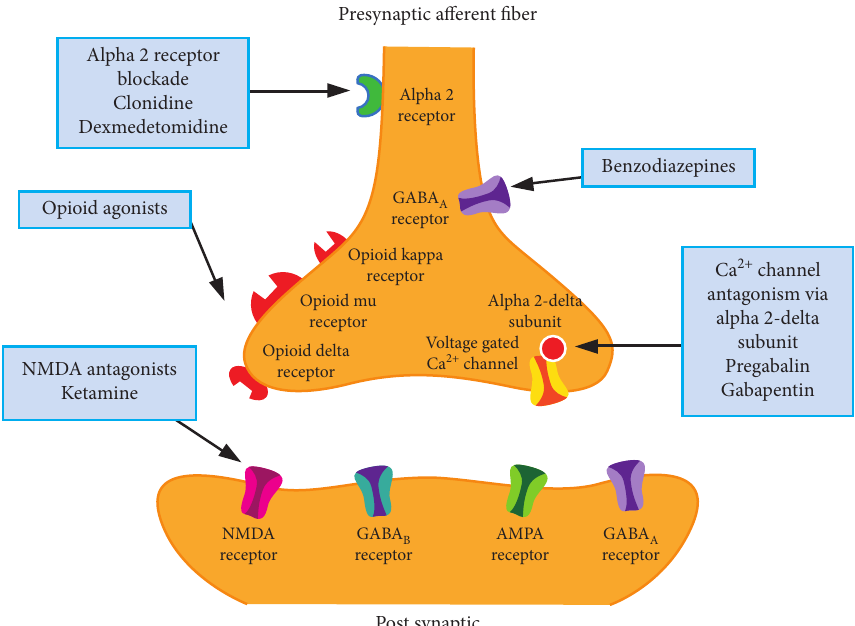
Figure 2: Receptors affecting pain